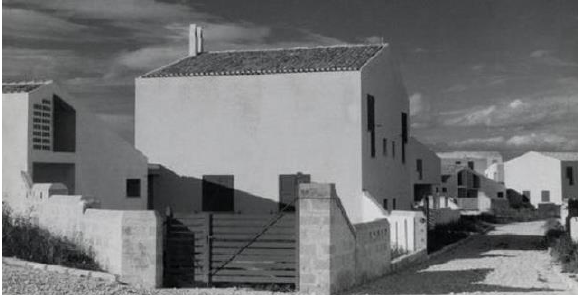
Figure 2. Historical photo of one of the housing aggregations of the new village “La Martella” (© Archivio storico Triennale di Milano Image Copyright